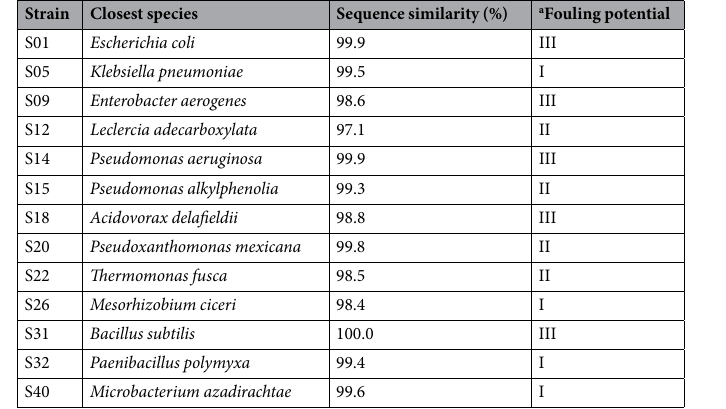
Table 1. Bacterial strains used in this study. a Fouling potential: The degrees of fouling potential of the isolated strains were determined with cross-flow membrane filtration system (CFMFS) when cultivated as single-culture and categorized as follow: high, I; moderate, II; low: III 8